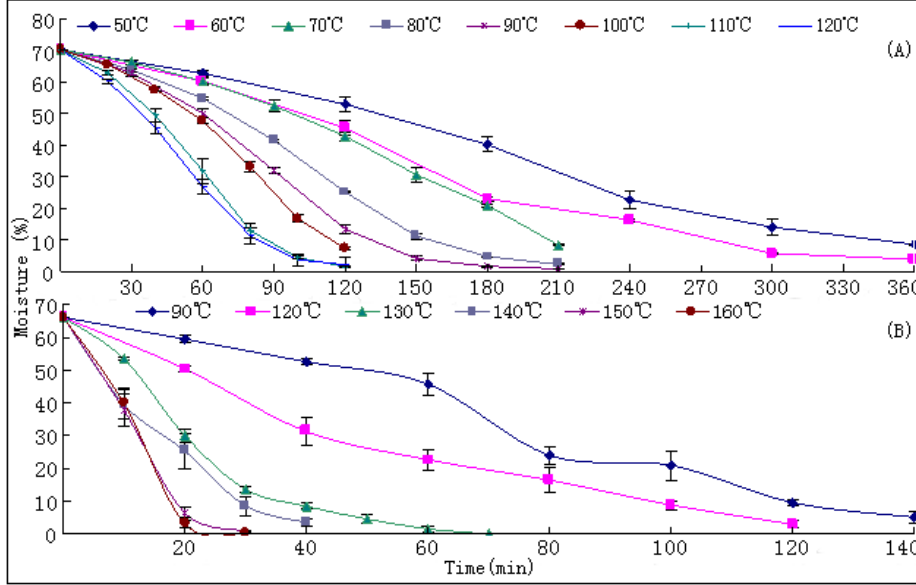
Figure 2. The drying curves of samples at different temperature. ( A ) results of experiment 1; ( B ) results of experiment